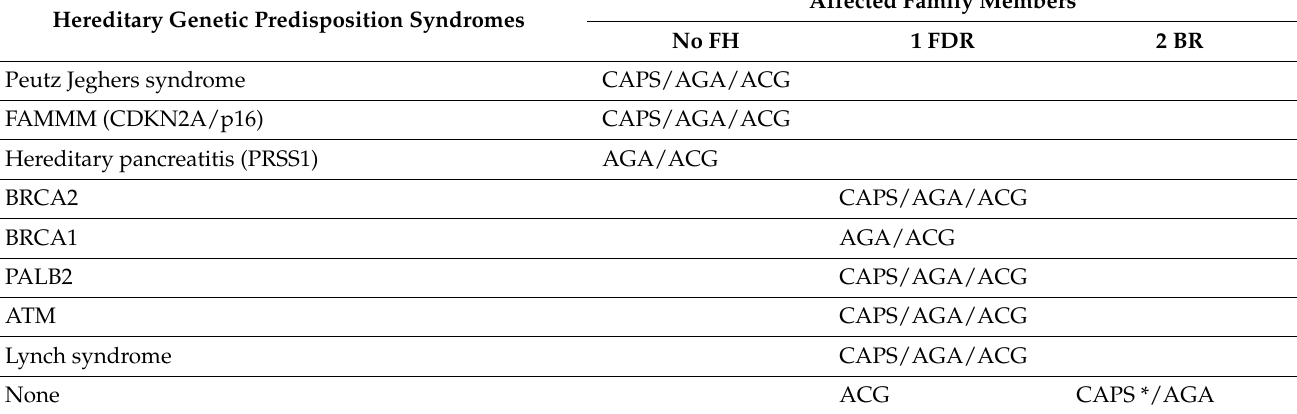
Table 3. Screening guidelines for hereditary pancreatic cancer patients according to the International Cancer of the Pancreas Screening (CAPS) Consortium guidelines, American Gastroenterological Association (AGA) guidelines and the American College of Gastroenterology (ACG) guidelines